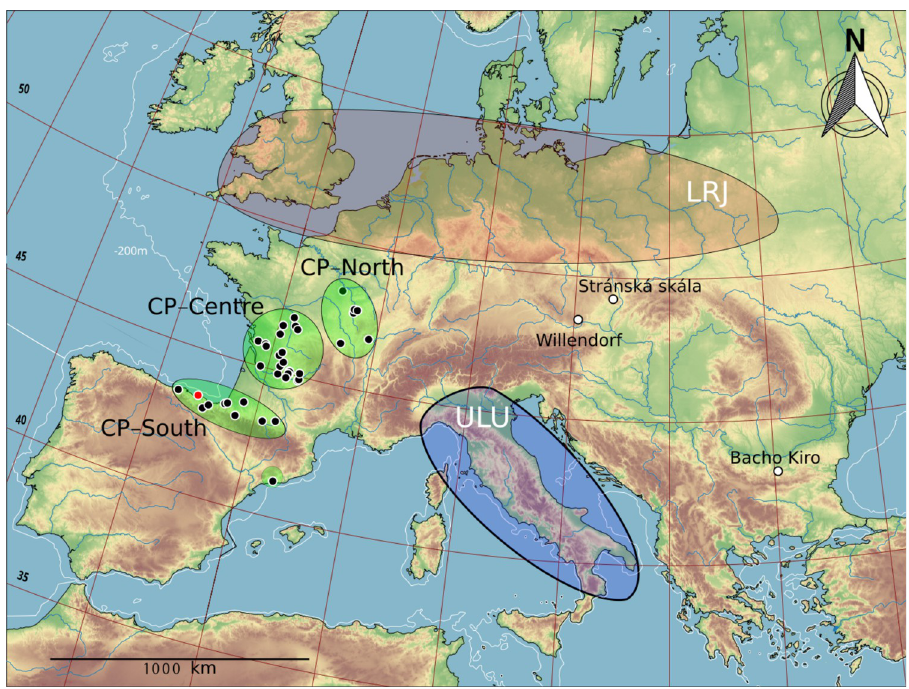
Fig 1. Distribution map of the so-called transitional technocomplexes. CP: Chaˆtelperronian; LRJ: Lincombian- Ranisian-Jerzmanowician; ULU: Uluzzian. Base cartographic data obtained from the European Environment Agency (free of use, downloadable at https://www.eea.europa.eu/ds_resolveuid/070F2DAD-1AED-4B9B-950F- 0047E5ADDF35. Rivers and bathimetry obtained from Natural Earth (free for use). DEM built up with QGIS 2.18. Infographics made with